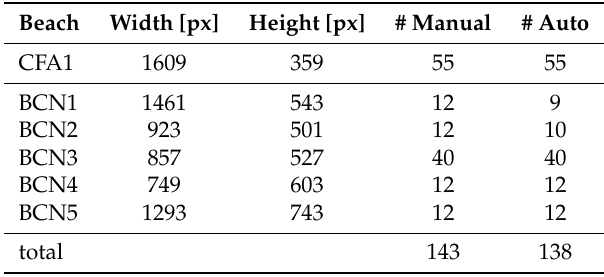
Table 1. Sizes in pixels (2 px = 1 m) of the planviews of each beach and corresponding number of planviews used for manual and automatic shoreline detection.